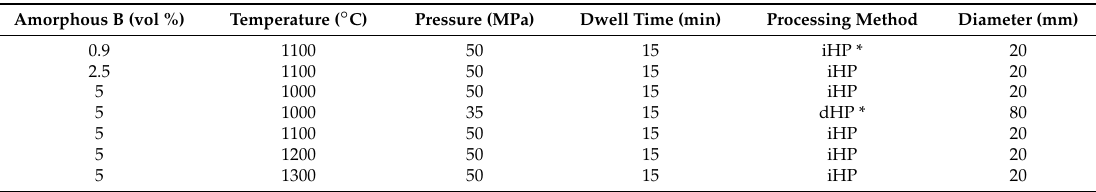
Composition and processing parameters for the manufacturing of titanium matrix composites